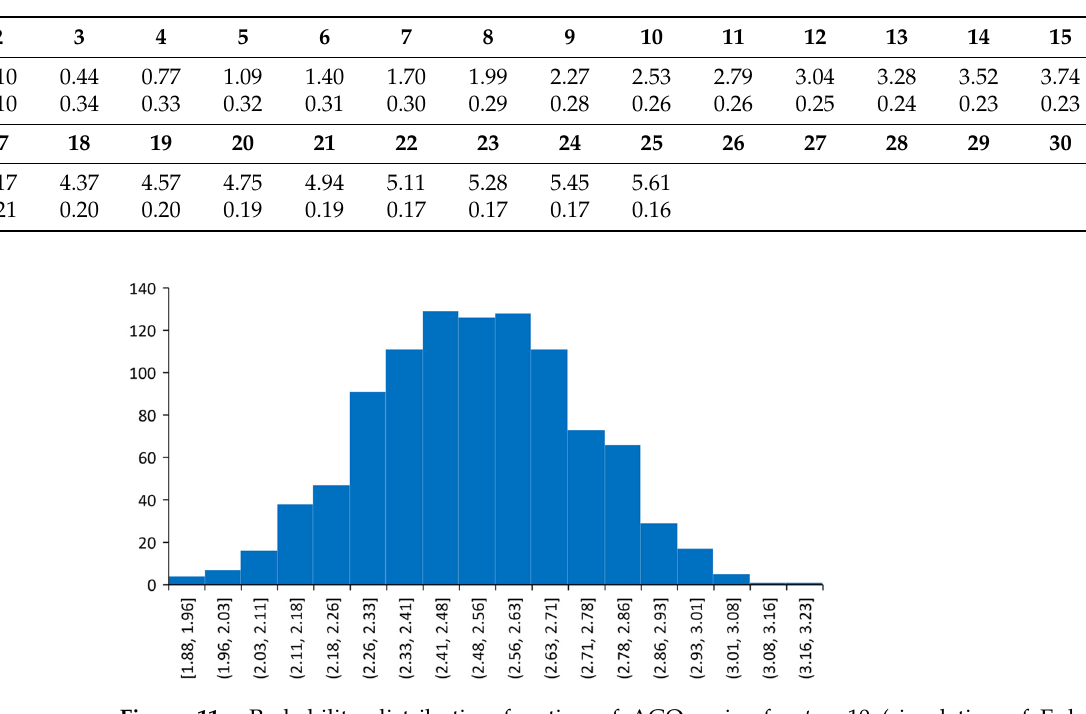
Figure 11. Probability distribution function of AGO series for t = 10 (simulation of Euler–Maruyama equation). Applying Equation (5) on the expected IAGO outcomes, we obtain the fi rst di ff erence series of displacements for t = 2, 3, …, 25 reconstructed; see Table 14. Table 14. The fi rst di ff erence series of displacements reconstructed.